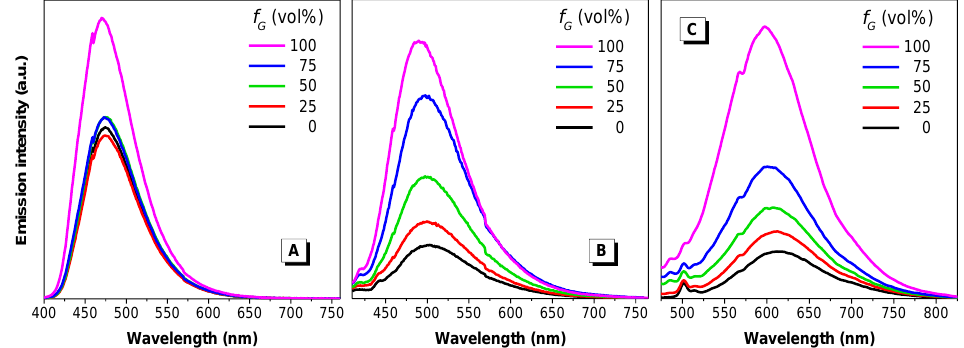
Figure 6. Emission spectra of dyes 1 ( A ), 2 ( B ) and 3 ( C ) in ethylene glycol/glycerol mixtures, where fG indicates glycerol fraction. Concentration = 10 µM . Excitation wavelength: 388, 390 and 437 nm, respectively. Note: in panel C, the peak at approx. 500 nm corresponds to the Raman scattering of the solvent.